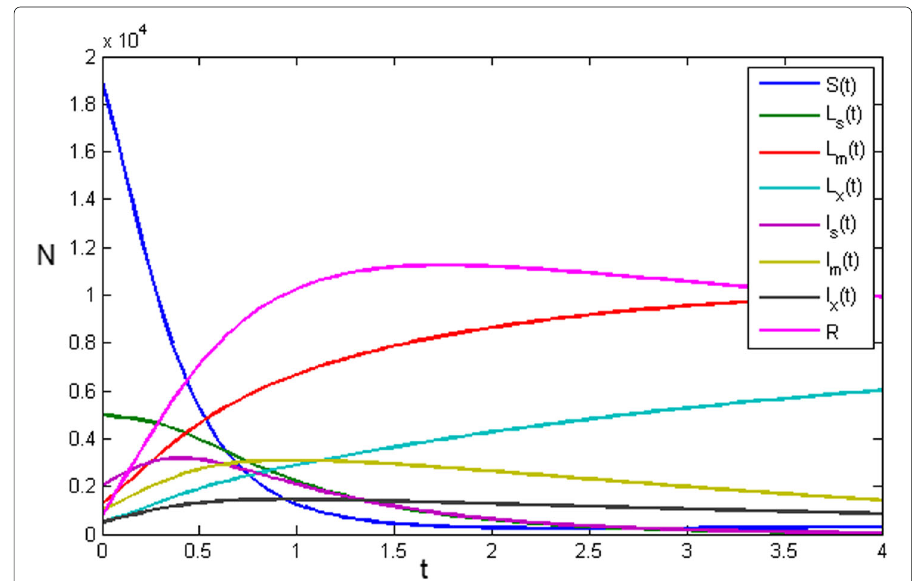
Fig. 4 Simulations of multi-strain TB model showing the various classes with θ = 0, ξ = 0